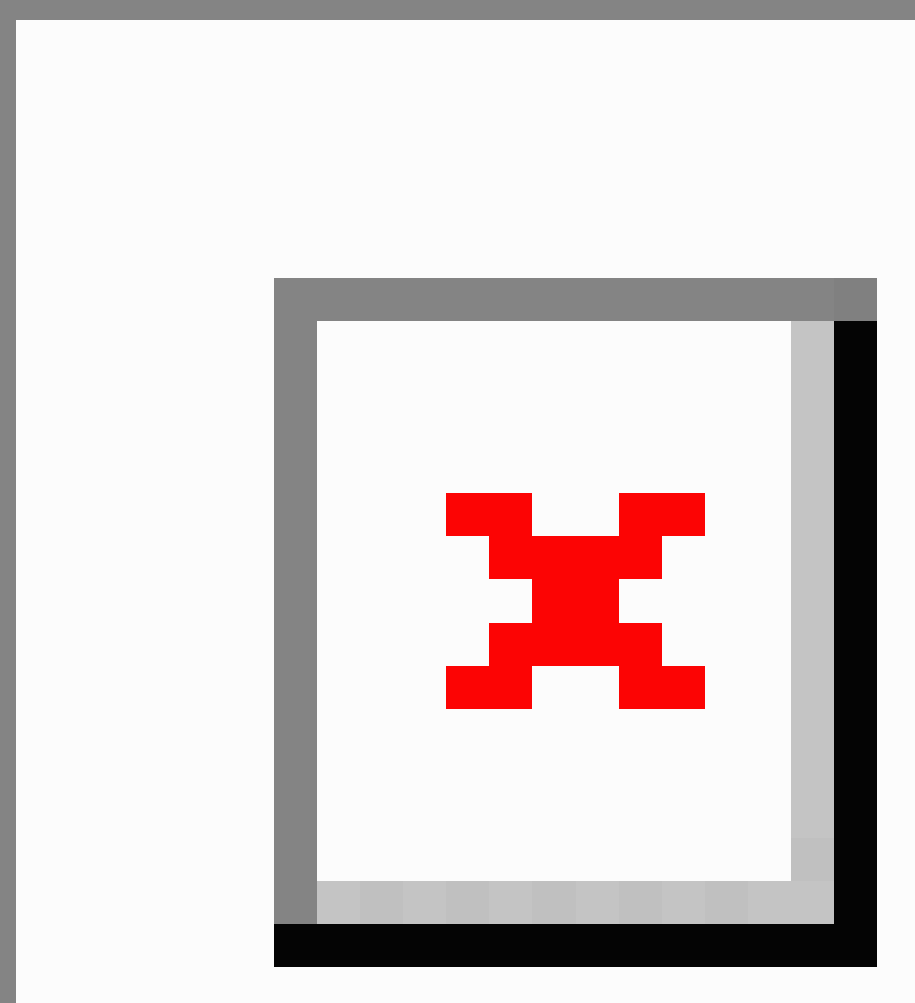
Figure 1. Flowchart of appetite assessment and main results after 6